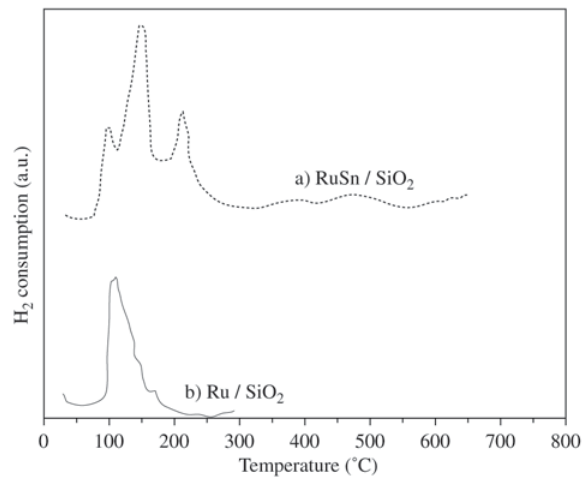
Figure 5. TPR profiles for the catalysts Ru/SiO pretreated in air at 500